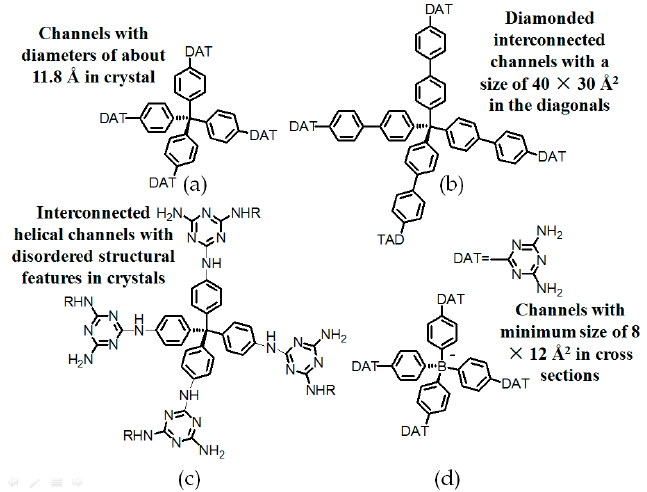
Figure 19. ( a ) Structure of the building motif 20 ; ( b ) Structure of motif 21 ; ( c ) Structures of motif 22a (R = H), 22b (R = CH 2 CH 2 OCOCH 3 ), and 22c (R = CH 2 CH 2 OH); ( d ) Structure of motif 23 .